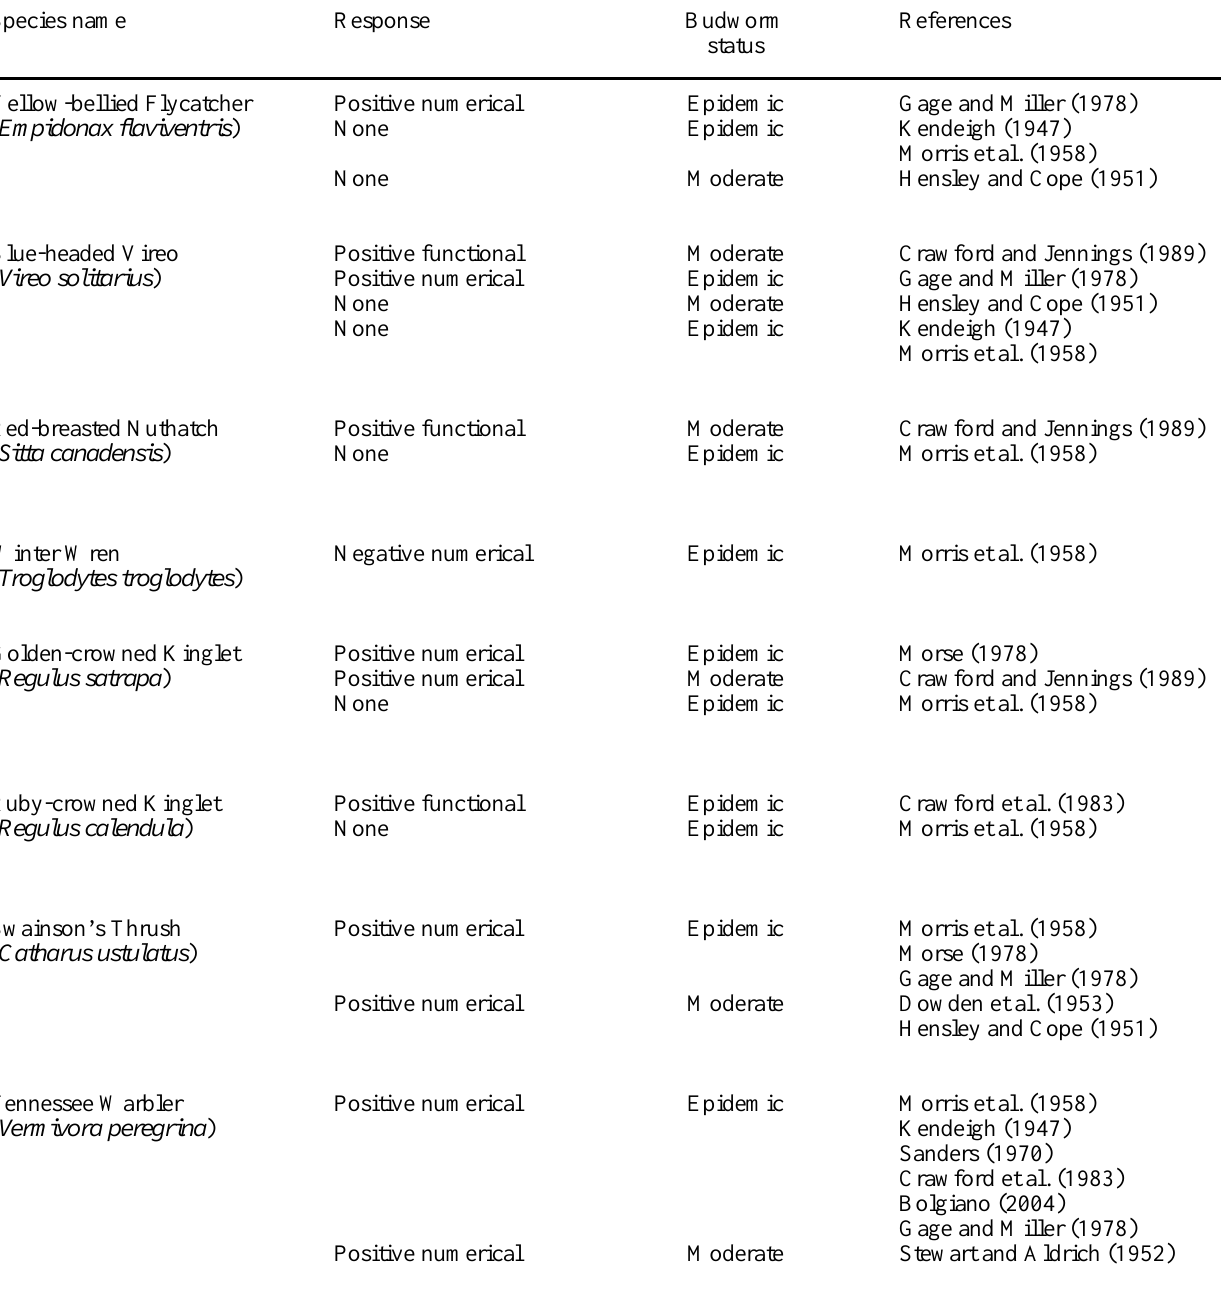
Table A1-1. Summary of species response to spruce budworm ( Choristoneura fumiferana (Clem.)) from the literature. A numerical response indicates a change in the number of individuals in conjunction with a change in budworm abundance. A functional response indicates a change in behavior in conjunction with a change in budworm